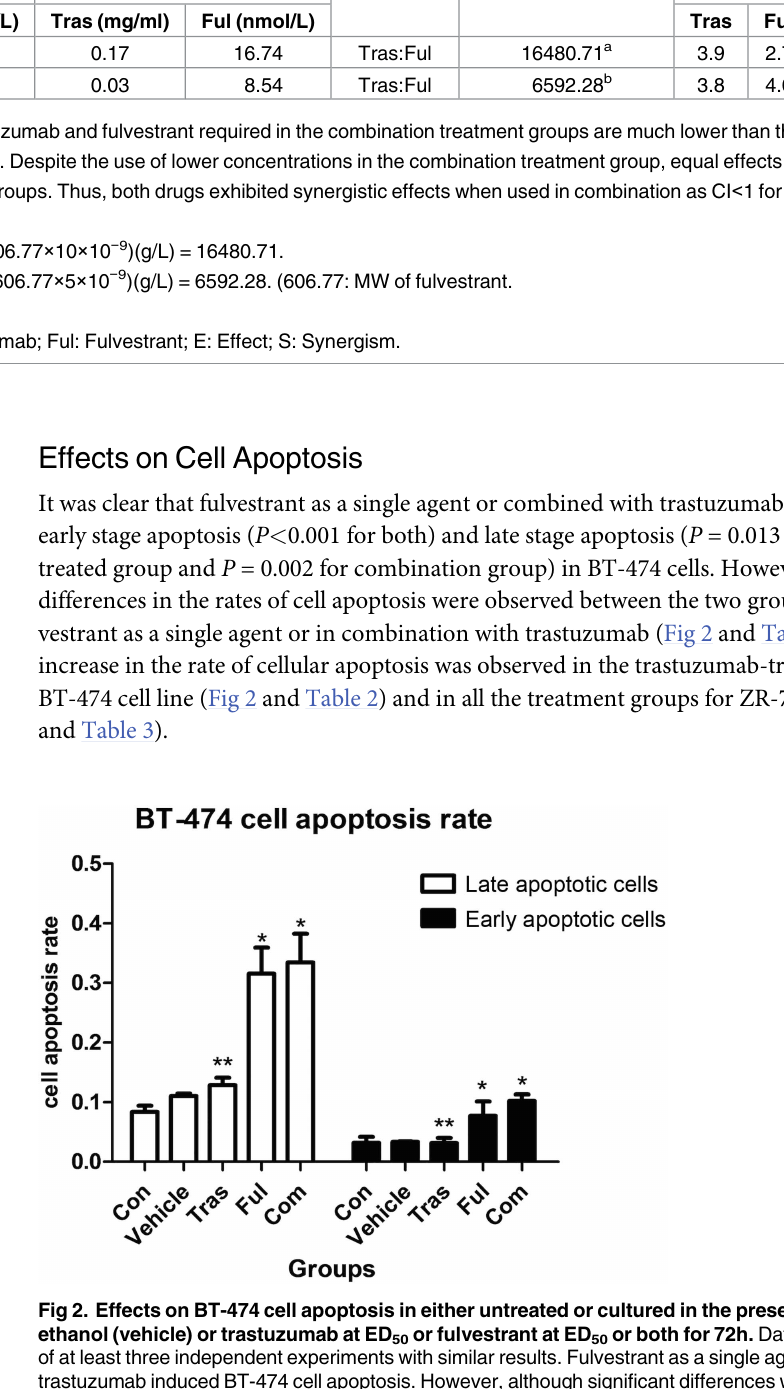
Fig 2. Effects on BT-474 cell apoptosis in either untreated or cultured in the presenceof absolute ethanol (vehicle) or trastuzumab at ED 50 or fulvestrant at ED 50 or both for 72h. Data are representative of at least three independentexperimentswith similar results. Fulvestrant as a singleagent or combinedwith trastuzumab inducedBT-474 cell apoptosis.However, although significantdifferenceswere observed betweenthe trastazumab-treatedand combination groups, no statistical differences were observed between the fulvestrant-treated and combination groups. * P < 0.05comparedwith control group. ** P < 0.05compared with combination